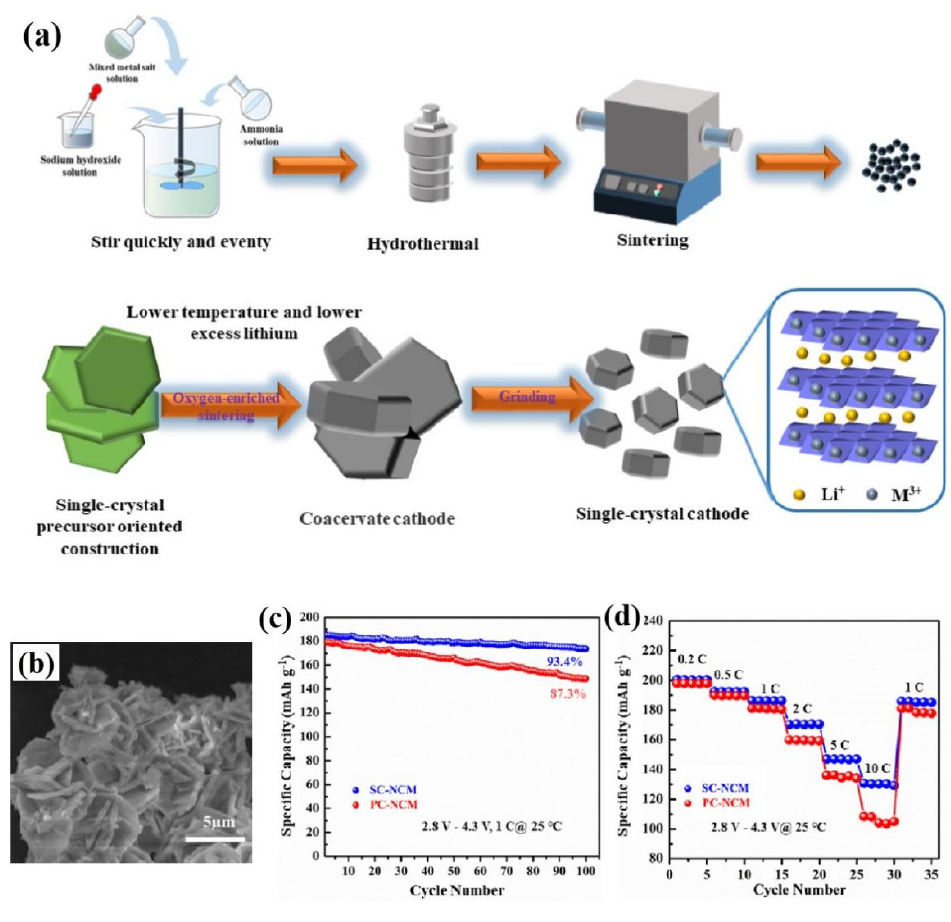
Figure 6. Research content reproduced from Ref. [244]. ( a ) The schematic diagram for the preparation process and ( b ) SEM image for SC-NCM. The comparison of ( c ) cycling performance and ( d ) rate capability between SC-NCM and PC-NCM, Copyright 2022, American Chemical Society.